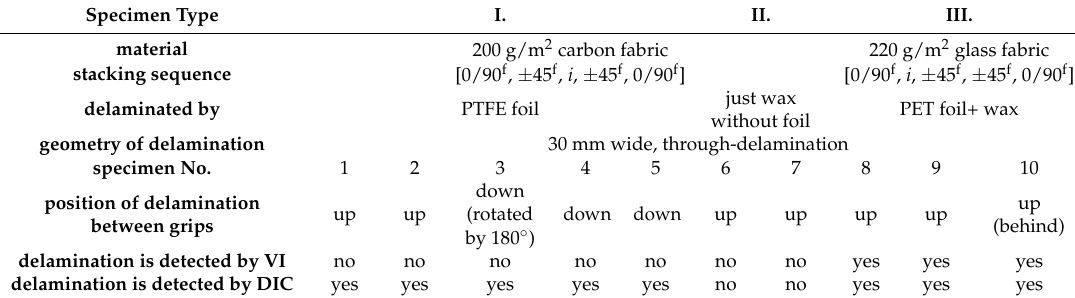
Table 1. Sample classifications, compositions and results